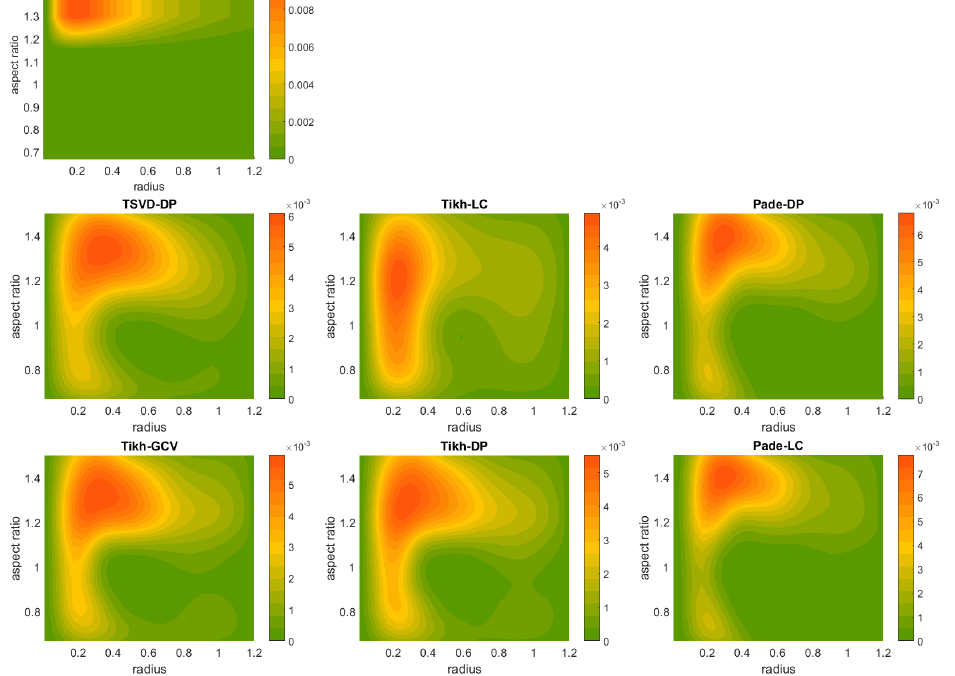
Figure A1. Retrieved shape-size distributions from synthetic data produced with RI: 1.5 + 0.01i, 1% data error, the size distribution No. 1 and prolate particle ensembles. The uppermost plot corresponds to the initial shape-size